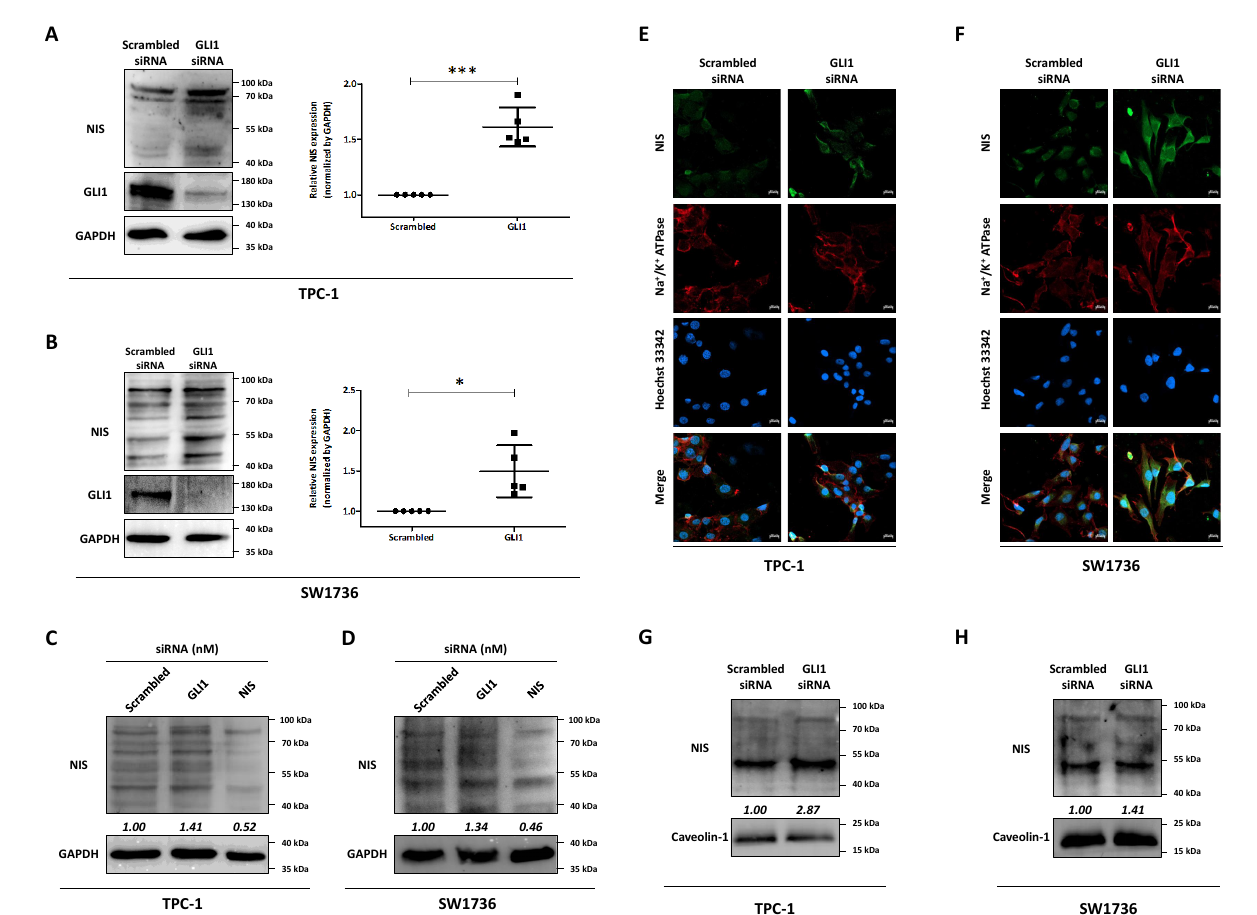
Figure 2. Changes in endogenous NIS expression and its localization in GLI1-inhibited thyroid cancer cells. Both TPC-1 and SW1736 cells were treated with scrambled siRNA, GLI1 siRNA or NIS siRNA for 48 h. ( A ) Changes in NIS and GLI1 expression induced by GLI1 siRNA treatment in TPC-1 cells. GAPDH was used as an internal control. Mean ± SD values from five independent experiments are presented. *** p < 0.001 (Student’s t -test). ( B ) Evaluation of NIS expression via GLI1 knockdown in SW1736 cells. Mean ± SD values from five independent experiments are presented. * p < 0.05 (Student’s t -test). Western blot analysis for NIS protein with scrambled siRNA, GLI1 siRNA or NIS siRNA treatment to TPC-1 cells ( C ) and SW1736 cells ( D ). Immunofluorescence images showing localization of endogenous NIS expression in TPC-1 cells ( E ) and SW1736 cells ( F ). Scale bar: 20 µ m. Expression of endogenous NIS protein in plasma membrane fraction by GLI1 knockdown in TPC-1 cells ( G ) and SW1736 cells ( H ). Caveolin-1 were used as loading controls for plasma membrane proteins. Raw data is presented in Figures